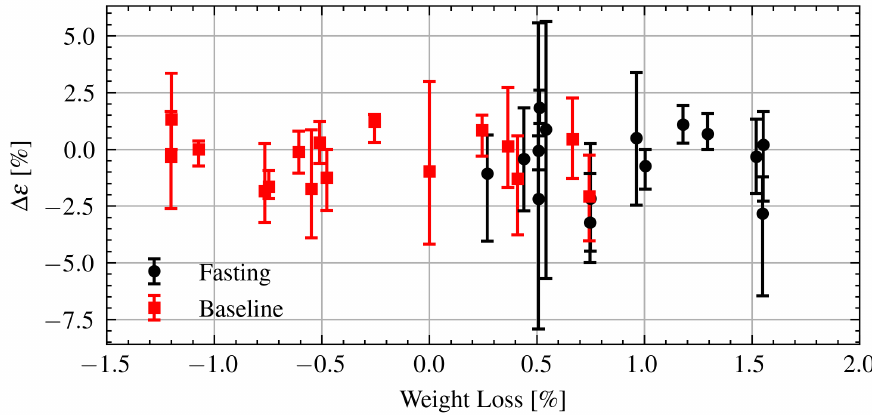
Figure 14. Estimated change in permittivity versus change in weight of fasting and baseline volun- teers. Dots are measurement session medians and error bars are minimum and maximum